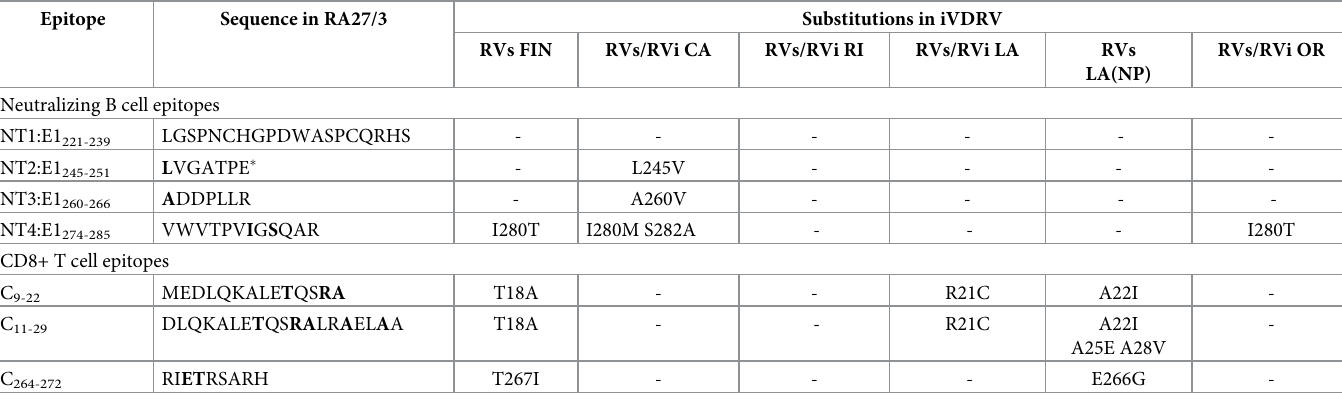
Table 2. Substitutions in B and T cell epitopes in